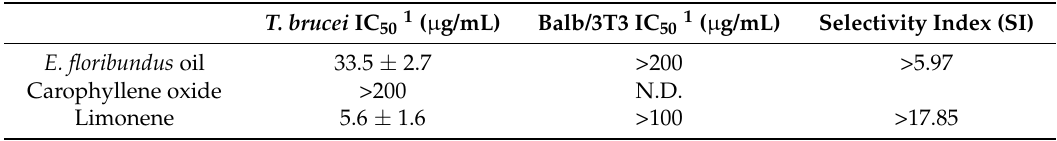
Table 5. Inhibition of T. brucei and Balb/3T3 fibroblast